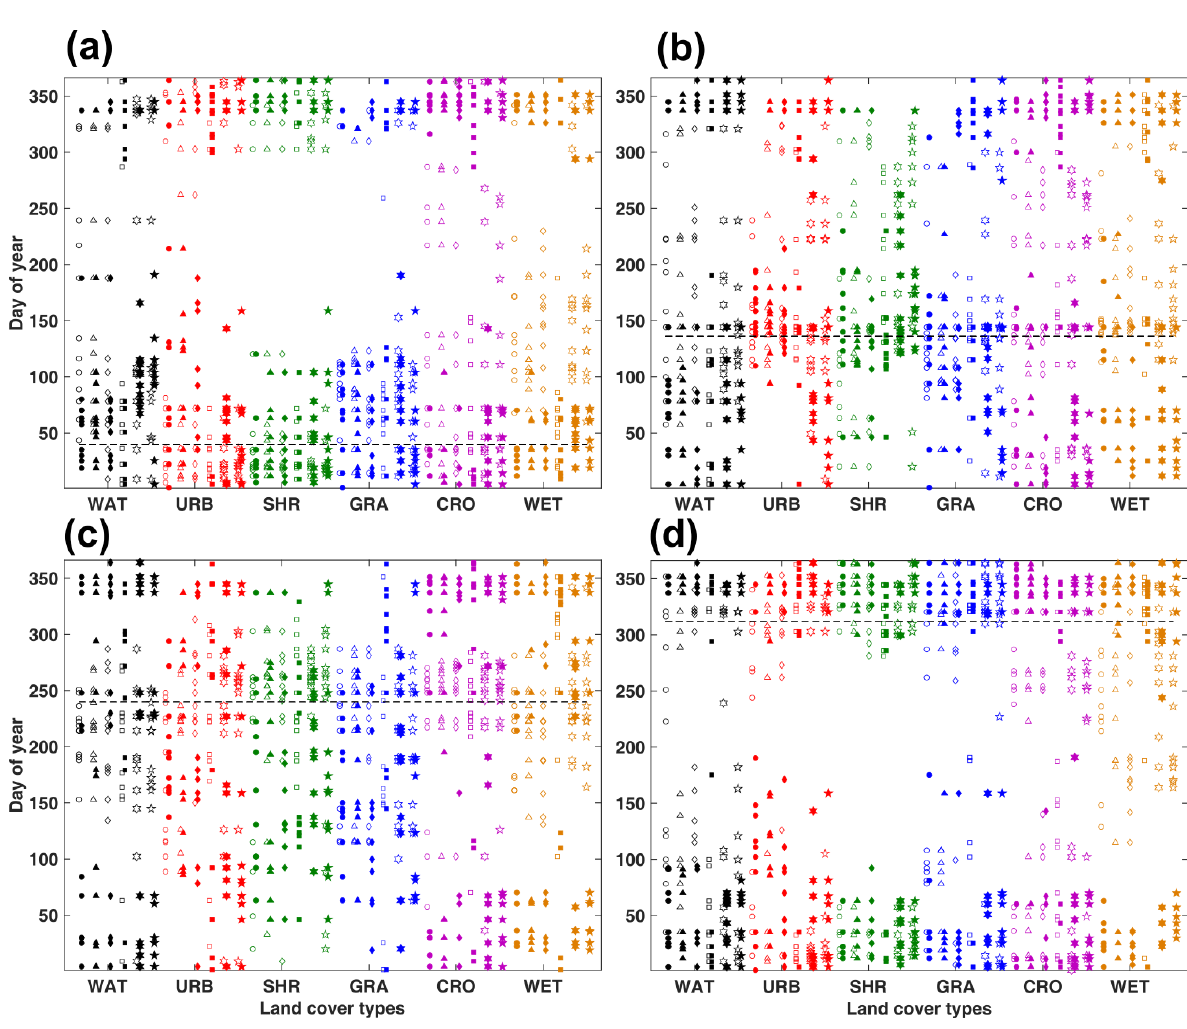
Figure 3. Distribution of the day of year (DOY) for maximum R 2 (not filled marker) and minimum RMSE (filled marker) value at each year from 2001 to 2012. The corresponding base date (dash line) is ( a ) 9 February (DOY: 40), ( b ) 16 May (DOY: 136), ( c ) 28 August (DOY: 240) and ( d ) 8 November (DOY: 312) for year 2001, respectively. The markers for six Landsat-like bands are circle, triangle, diamond, square, hexagram and pentagram, respectively. The color for each land cover type is black (WAT: water), red (URB: urban), green (SHR: shrub), blue (GRA, grassland), violet (CRO: cropland) and brown (WET: wetland). The meaning of marker and color for symbols is the same for Figure